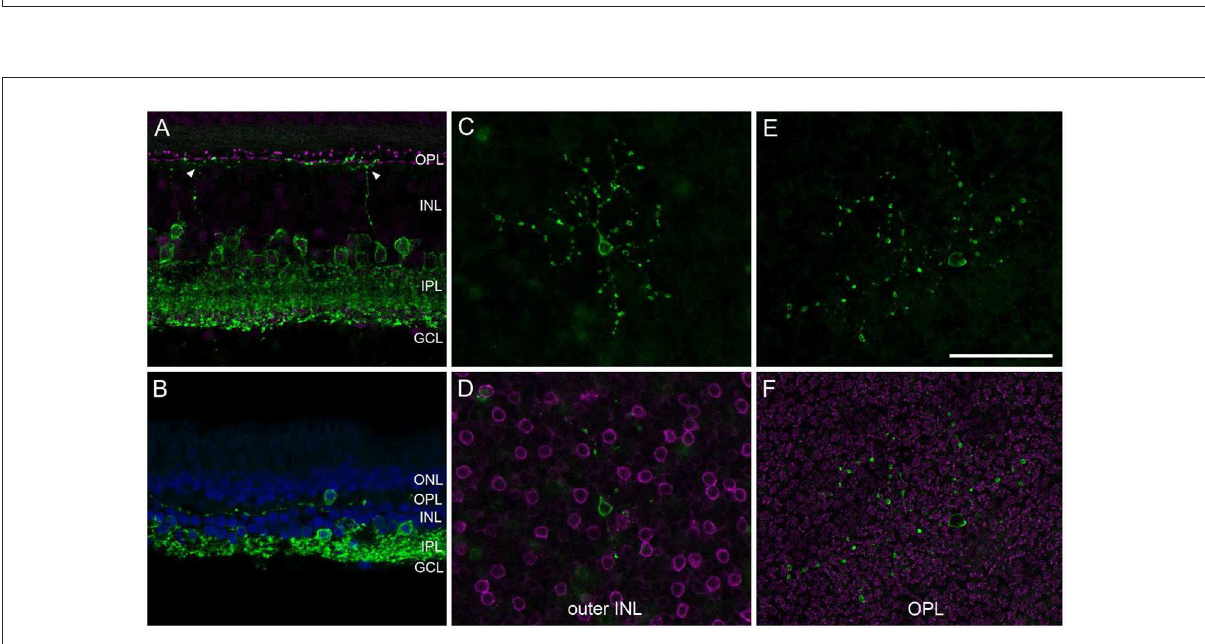
FIGURE4 Misplaced glycinergic amacrine cells in the marmoset retina . Vibratome sections or whole mount pieces were immunolabeled with GlyT1 (green) and Ctbp2 [magenta in (A,F) ] or PKC α [magenta in (D) ], and counterstained with DAPI [blue in (B) ]. (A) Central vibratome section with two glycinergic cells sending dendrites into the OPL. (B) Far peripheral vibratome section with a misplaced glycinergic AC (mGlyAC) within the OPL. (C–F) Two examples of mGlyACs with their cell bodies in the outer INL next to PKC α -labeled RBC bodies (C,D) and in the OPL in between Ctbp2-labeled ribbon synapses of photoreceptor terminals (E,F) , respectively. Z-projections of confocal image stacks are shown in (C,E) , confocal images of single sections in (D,F) . Scale bar in (E) 50 µ m for (A–F)